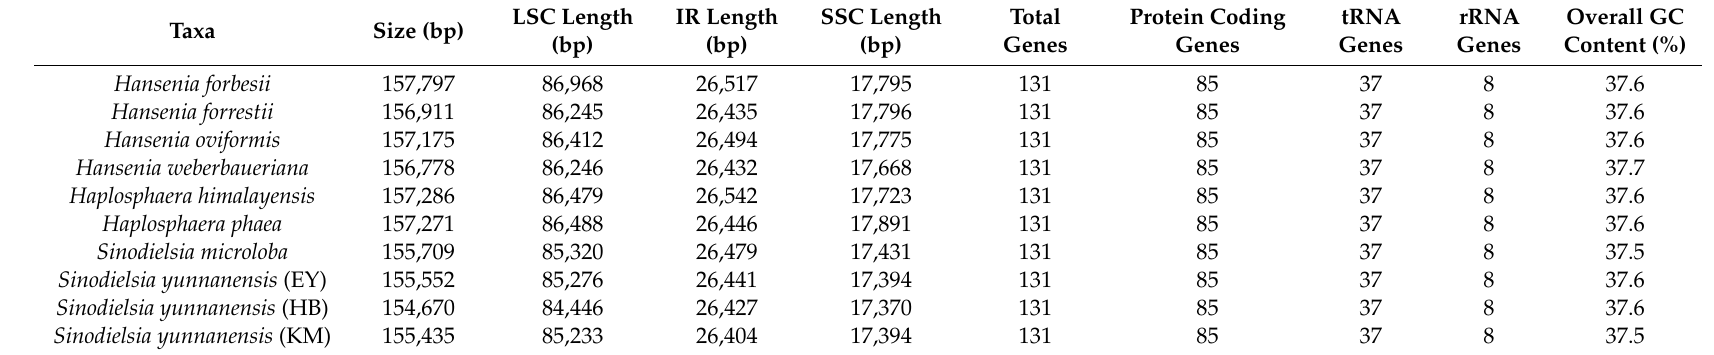
Table 1. The features of plastid genomes of eight Hansenia , Haplosphaera and Sinodielsia species (IRs: inverted repeats; LSC: large single-copy region; SSC: small single-copy